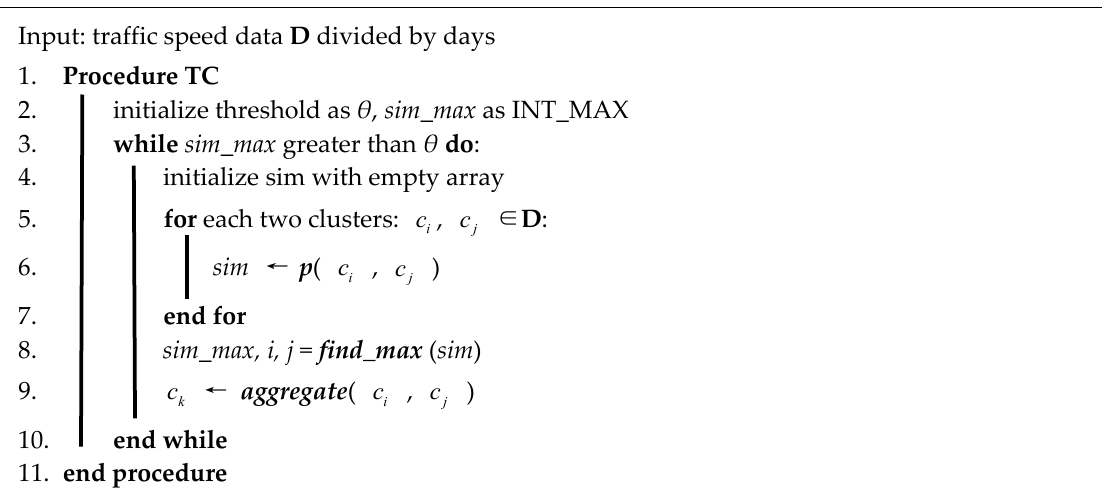
Algorithm 1: Temporal clustering analysis.